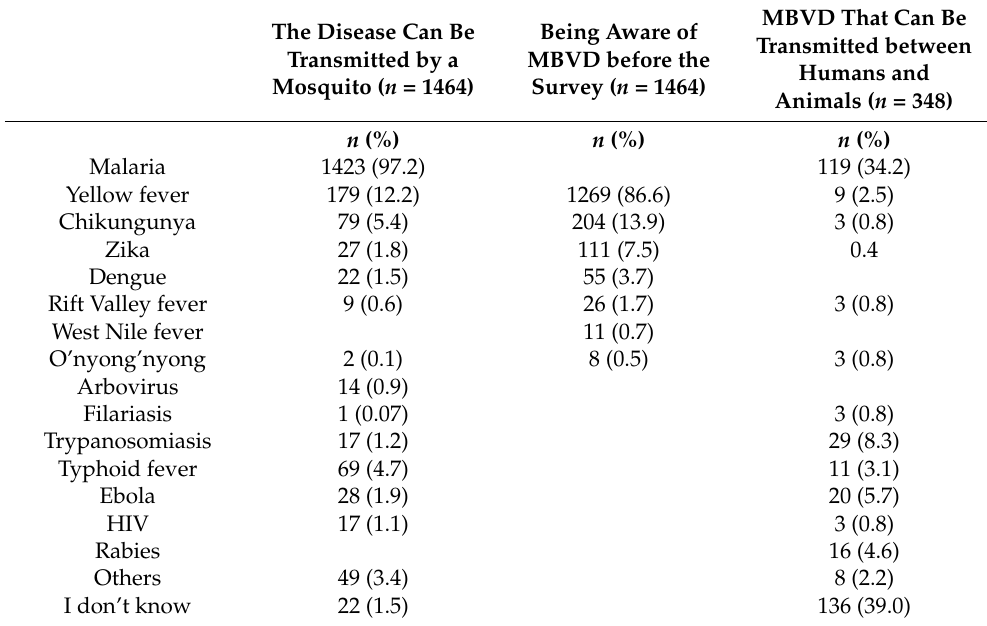
Table 4. Awareness of MBVDs and their transmission to humans and/or animals by